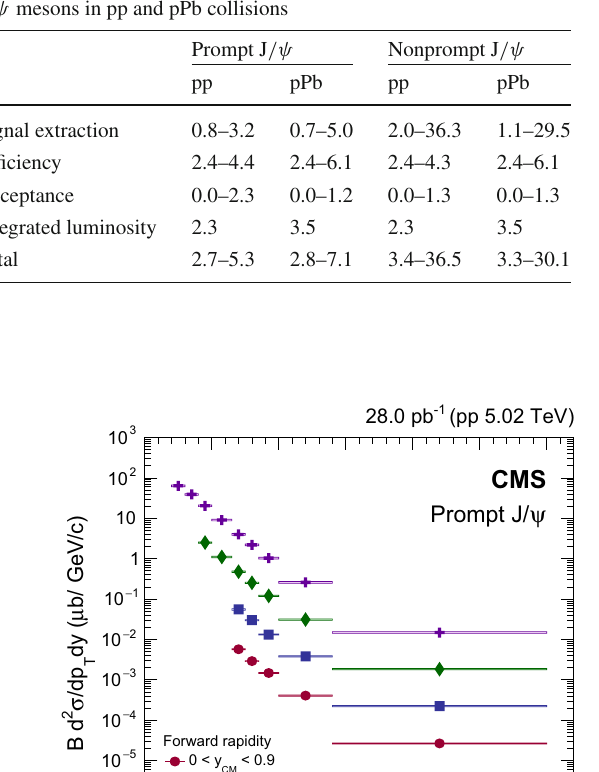
the shadedboxes showthesystematicuncertainties.Thefullycorrelated global uncertainty from the integrated luminosity determination, 2.3% for pp and 3.5% for pPb collisions, is not included in the point-by-point